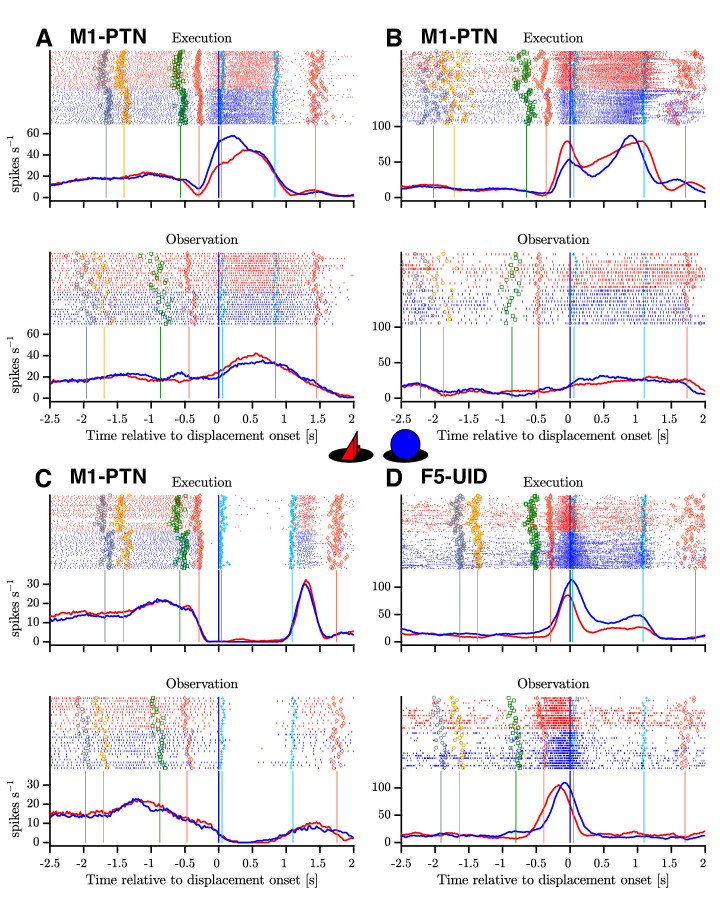
Example mirror neurons in M1 and F5.Raster and histogram representations of single neuron activity during execution (top panels) and observation (bottom panels). (A–C) Three M1-PTNs, showing varying relationships between execution and observation activity. (D) F5-UID showing substantial modulation during both conditions. Units in (A), (C) and (D) were recorded in M48, (B) was recorded in M49. Activity is aligned to object displacement (DO). Rasters are split by grasp (PG and WHG, objects shown in central inset) and condition for visualization purposes, although trials were presented in a pseudo-randomised order during recording. Single trial events are indicated on raster plots (LCDon, Object Cue, Go, HPR, HO, HOFF, HPN), and median times relative to alignment are shown on histograms. Event colours are as shown previously (Figure 1C): LCDon - grey; Object Cue - orange; Go - green; HPR and HPN - magenta; HO and HOFF - cyan). For histograms, firing rates were calculated in 20 ms bins and boxcar-smoothed (200 ms moving average).